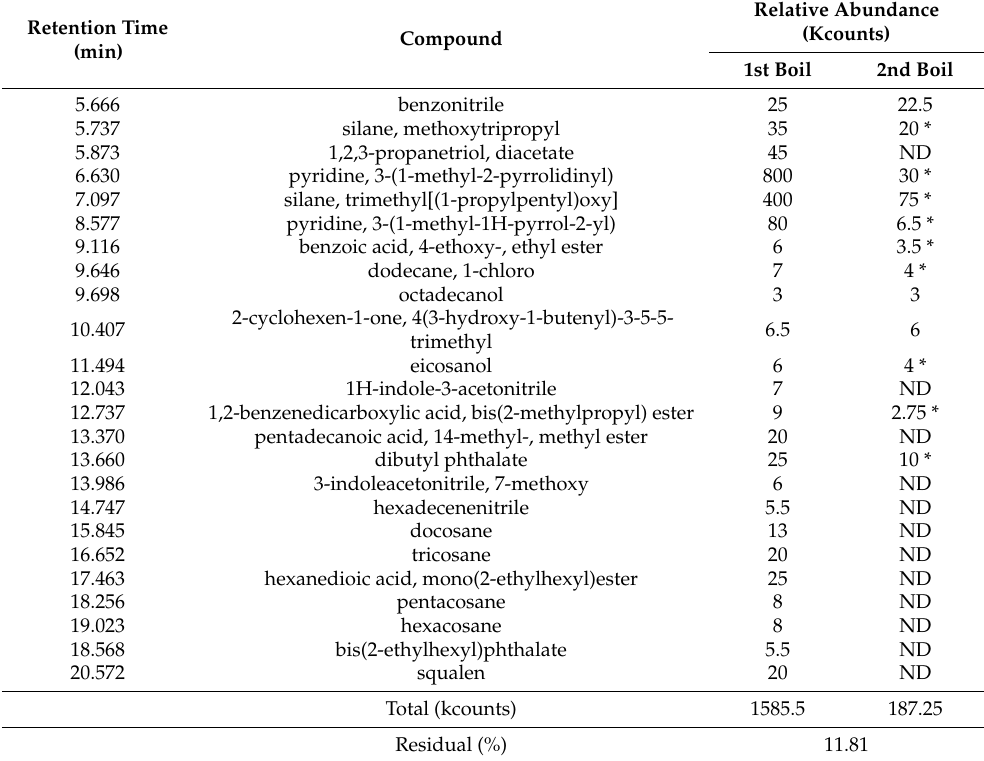
Table 1. Chemical characterization of cigarette butts treatment. Relative abundance (kcounts) of different compounds contained in the wastewater from first and second boiling of cigarette butts. Total represents the sum of the relative abundance of compounds in each boiling sample, whereas the residual (%) was obtained by comparing the total abundance between first and second boiling samples. Data are means of 3 different replicates. Asterisks represent significant differences ( p < 0.05) between first and second boiling samples. Instrument detection limit < 400 counts. ND, not